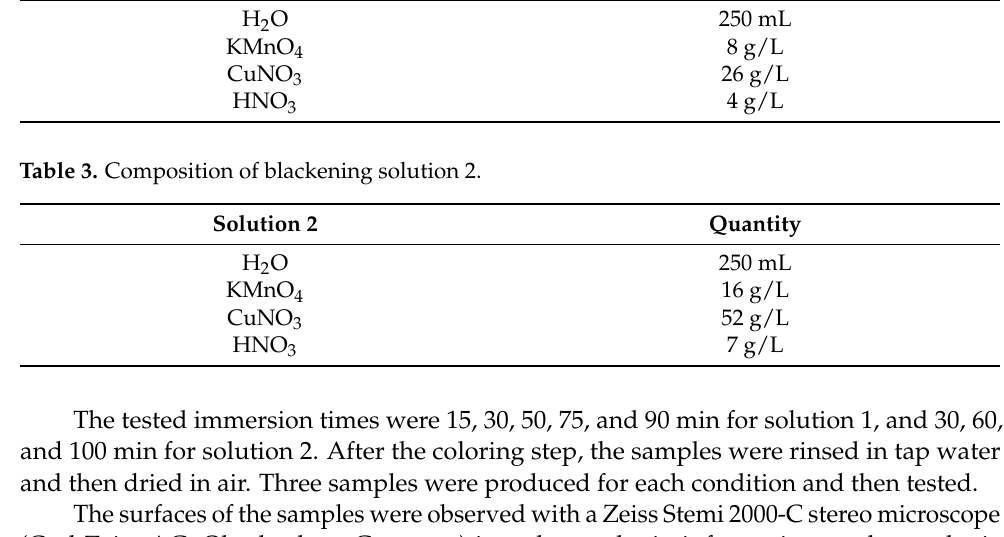
Table 2. Composition of blackening solution 1.